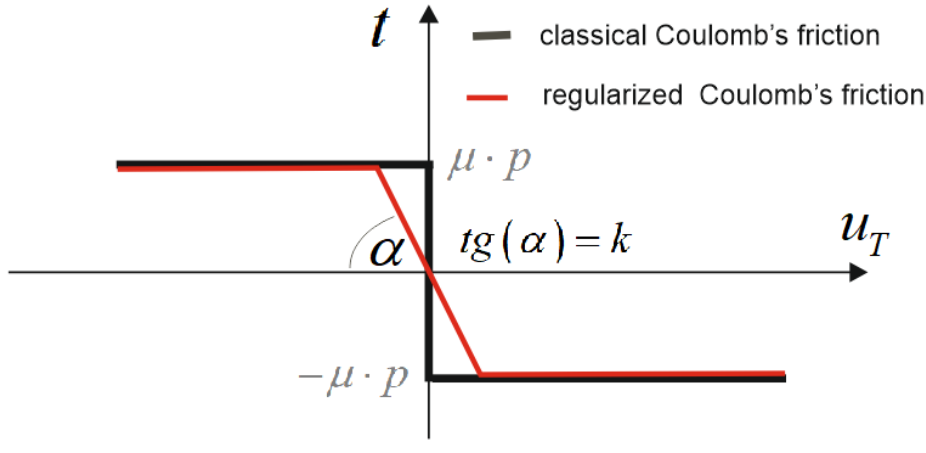
Figure 9. Classical and elastoplasticity-based (regularized) Coulomb’s friction models.